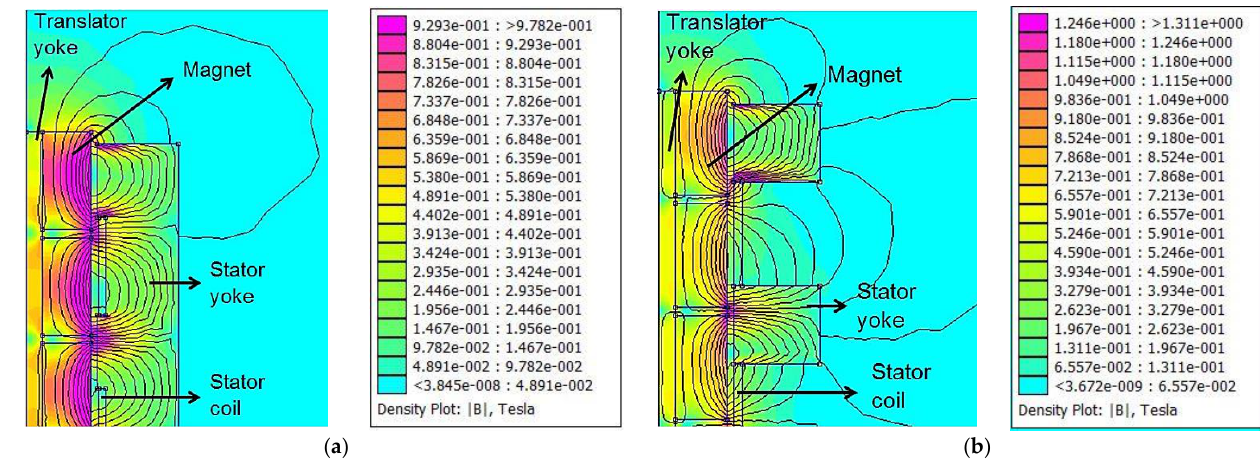
Figure 10. Absolute magnetic flux density (|B|) in ( a ) iron-cored LPMG and ( b ) semi iron-cored LPMG.